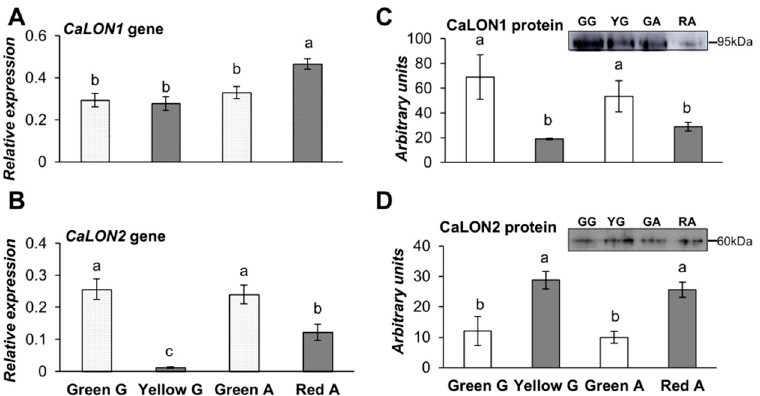
Figure 5. Expression analysis of ( A ) CaLON1 and ( B ) CaLON2 genes relative to ACTINE-100 by RT-qPCR, and Western blot analysis of the ( C ) CaLON1 and ( D ) CaLON2 proteins in green Galena (GG), yellow Galena (YG), green Alonso (GA), and red Alonso (RA) pepper fruits. Data are means ± standard error (SE) of three technical replicates of three biological samples. Different lower case letters indicate that data are significantly different according to the Kruskal-Wallis test at p < 0.05.